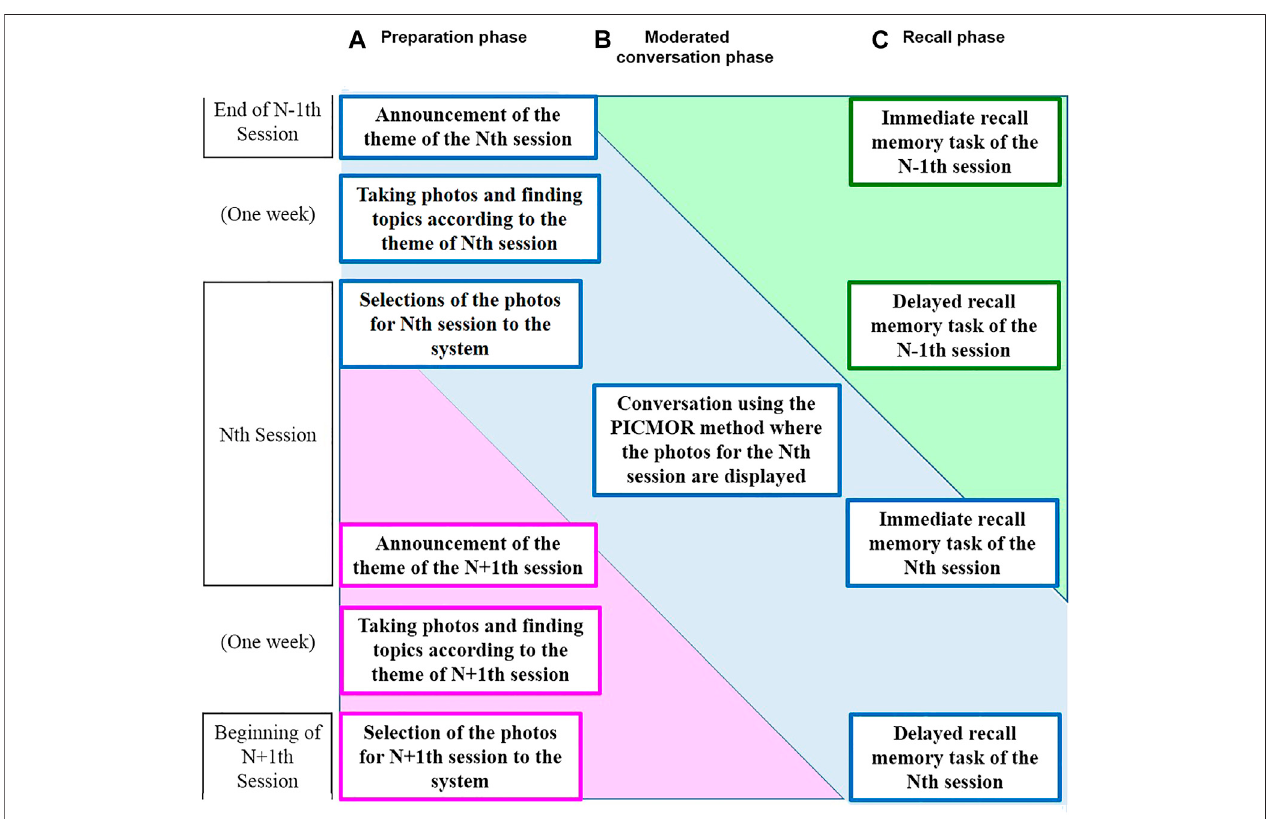
FIGURE 3 | A block diagram of the RCT based on the PICMOR program.